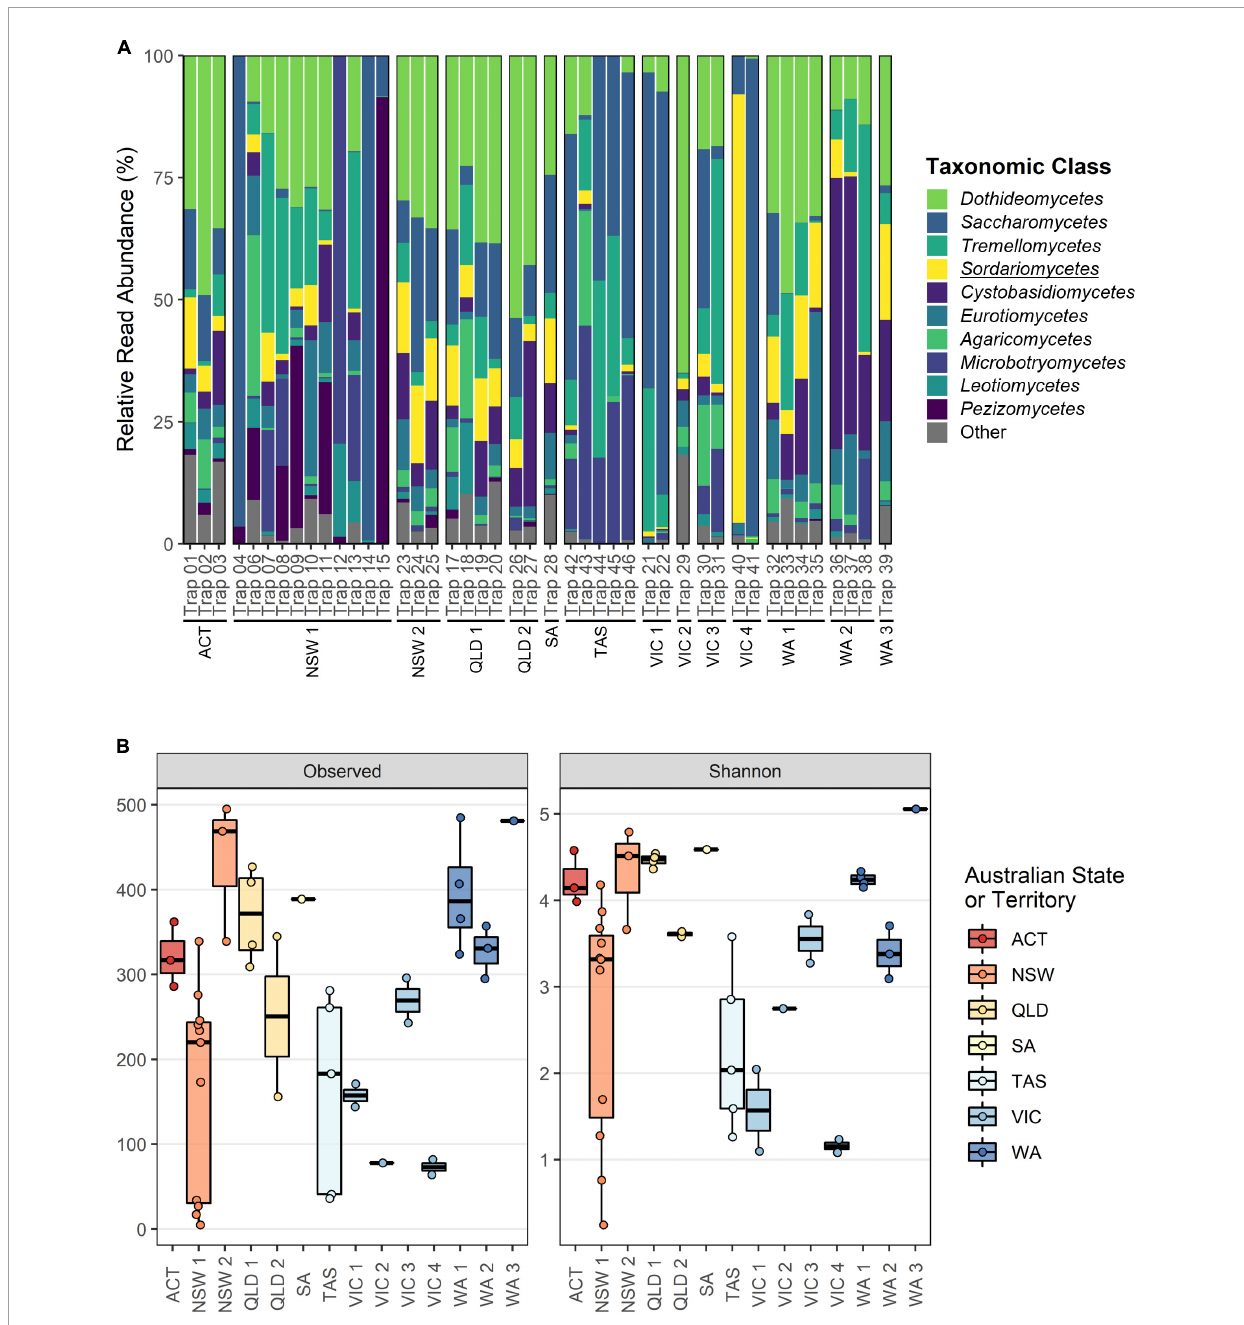
FIGURE2 Overview of fungal class composition and alpha diversity metrics for the ITS1 dataset separated according to collection batch. (A) Relative read abundance (RRA) of the top 10 taxonomic classes. All taxa outside of the top 10 and any unclassified ASVs have been grouped under “Other.” The class wherein the targeted Ophiostomatales reside is underlined. (B) Observed richness and Shannon diversity metrics with batches colored according to Australian State or Territory.